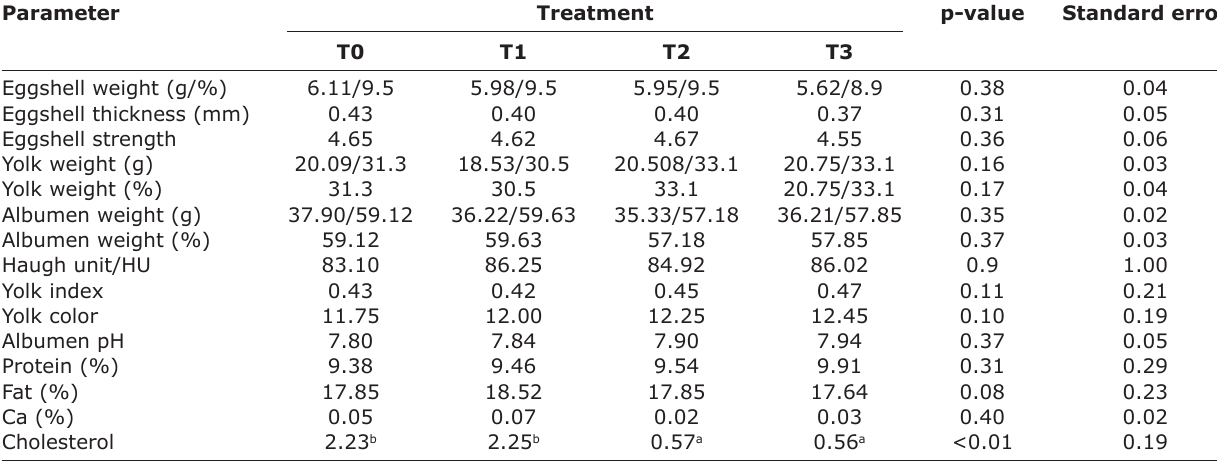
Table-3: The physical and chemical egg quality of Pengging duck which given symbiotic (inulin of gembili tuber and Lactobacillus plantarum) . Parameter